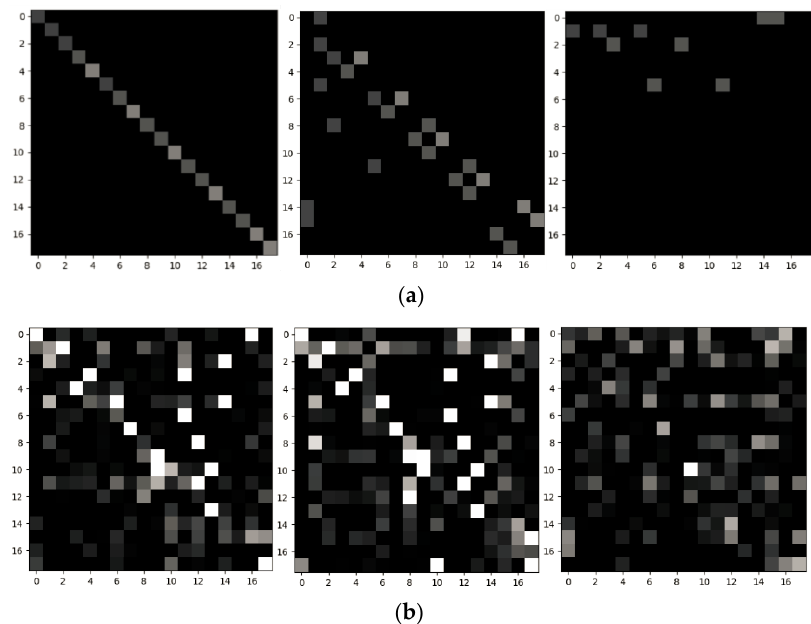
Figure 8. Visualization of the adjacent matrix of each subset in the Kinetics dataset. ( a ) The original adjacent matrix employed in ST-GCN [20]. ( b ) The adaptive adjacency matrix learned by our model.